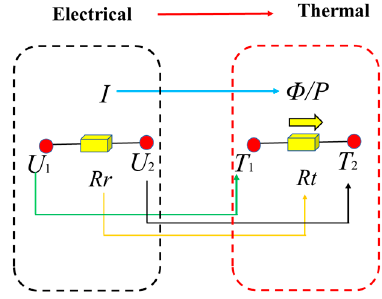
Figure 2. The theory of electrical to thermal.